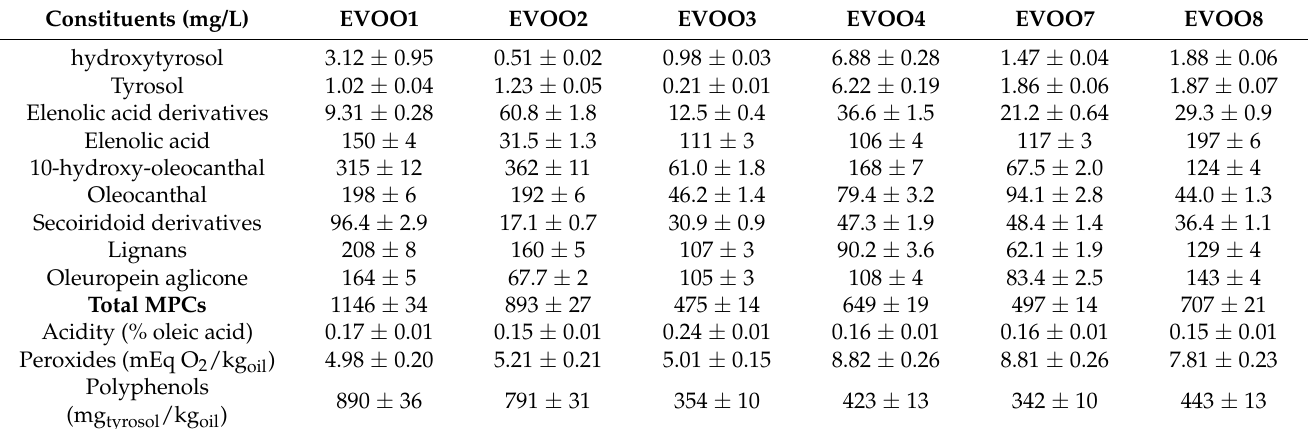
Table 1. Minor polar compounds (MPCs) present in the extra virgin olive oils